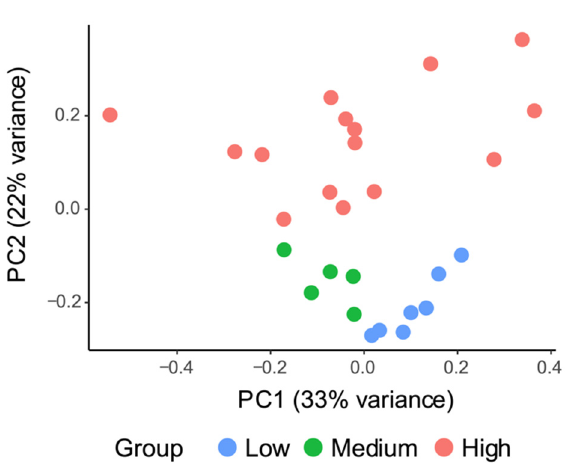
Figure 8. PCA plot based on gene functional abundance on KEGG level II predicted by PICRUSt2. Each point represents a sample, and the color blue, green and red represent the sample groups of low-, medium- and high-salinity, respectively.